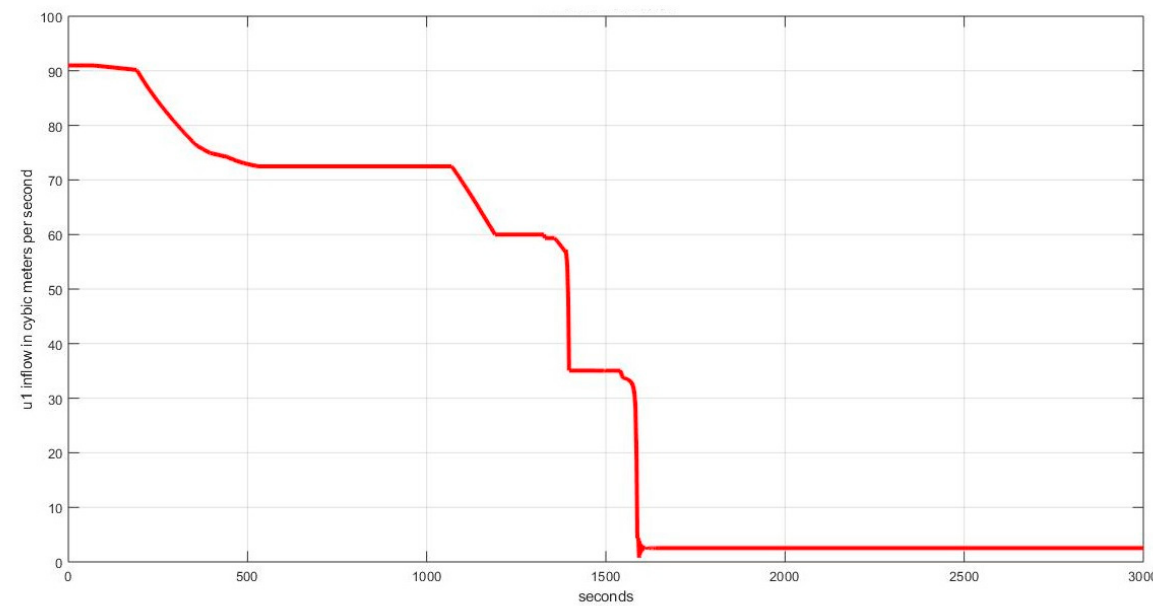
Figure 9. Desired water levels vs. time. T 0 at 25 m and T 1 , T 2 at 30 m.